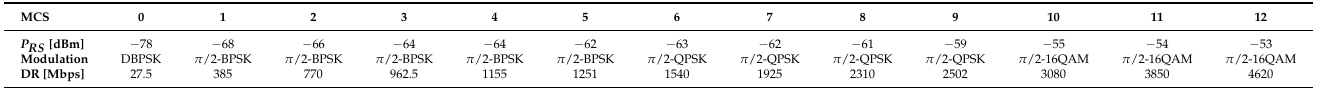
Table 1. Receiver sensitivity ( P RS ), modulation, and data rate (DR) used in IEEE 802.11ad for the different modulation and coding schemes (MCS)